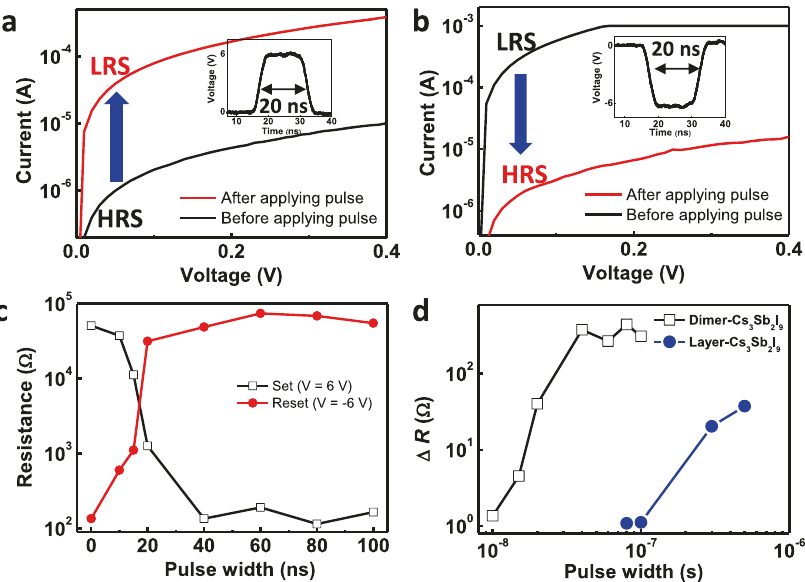
Fig. 4 Switching speed of HP RSM. I – V characteristics of dimer-Cs 3 Sb 2 I 9 RSM before and after application of ( a ) set pulse (6 V, 20 ns) and ( b ) reset pulse ( − 6 V, 20 ns). c Resistance changes of dimer-Cs 3 Sb 2 I 9 RSM device with different pulse widths. Amplitudes of applied voltage pulses are fi xed for set (6 V) and reset ( − 6 V) processes. d Resistance changes of dimer-Cs 3 Sb 2 I 9 RSM and layer-Cs 3 Sb 2 I 9 RSM devices by application of set pulses (6 V) with different pulse widths. Δ R is de fi ned as the ratio between initial resistance and changed resistance after pulse application. on ITO. The thickness of layer-Cs 3 Sb 2 I 9 was about 170 nm for 50 cycles. These results suggested that the dimer-Cs 3 Sb 2 I 9 RSM device could be operated with a fast switching speed of (Supplementary Fig. 13a). The fi lm had RMS roughness of 20 ns. For comparison, we also measured the switching speed of 36.1 nm, and average grain size = 290 ± 15 nm, as calculated using the RSM device that used layer-Cs 3 Sb 2 I 9 . DFT calculations the ASTM intercept procedure (Supplementary Fig. 13b – d) 60 . The predict that this device will have slower switching speed than the XRD of layer-Cs 3 Sb 2 I 9 had high intensity diffraction peak at 25.8°, RSM device that uses dimer-Cs 3 Sb 2 I 9 , because layer-Cs 3 Sb 2 I 9 has which is similar to previously reported spectra of Cs 3 Sb 2 I 9 with higher E mig [ V X ] (0.57 eV) than dimer-Cs 3 Sb 2 I 9 (0.47 eV). To layer structure (Supplementary Fig. 14) 38,39 . These results verify this prediction, we deposited the layer-Cs 3 Sb 2 I 9 thin fi lm indicated that the layer-Cs 3 Sb 2 I 9 fi lm was formed. We fabricated